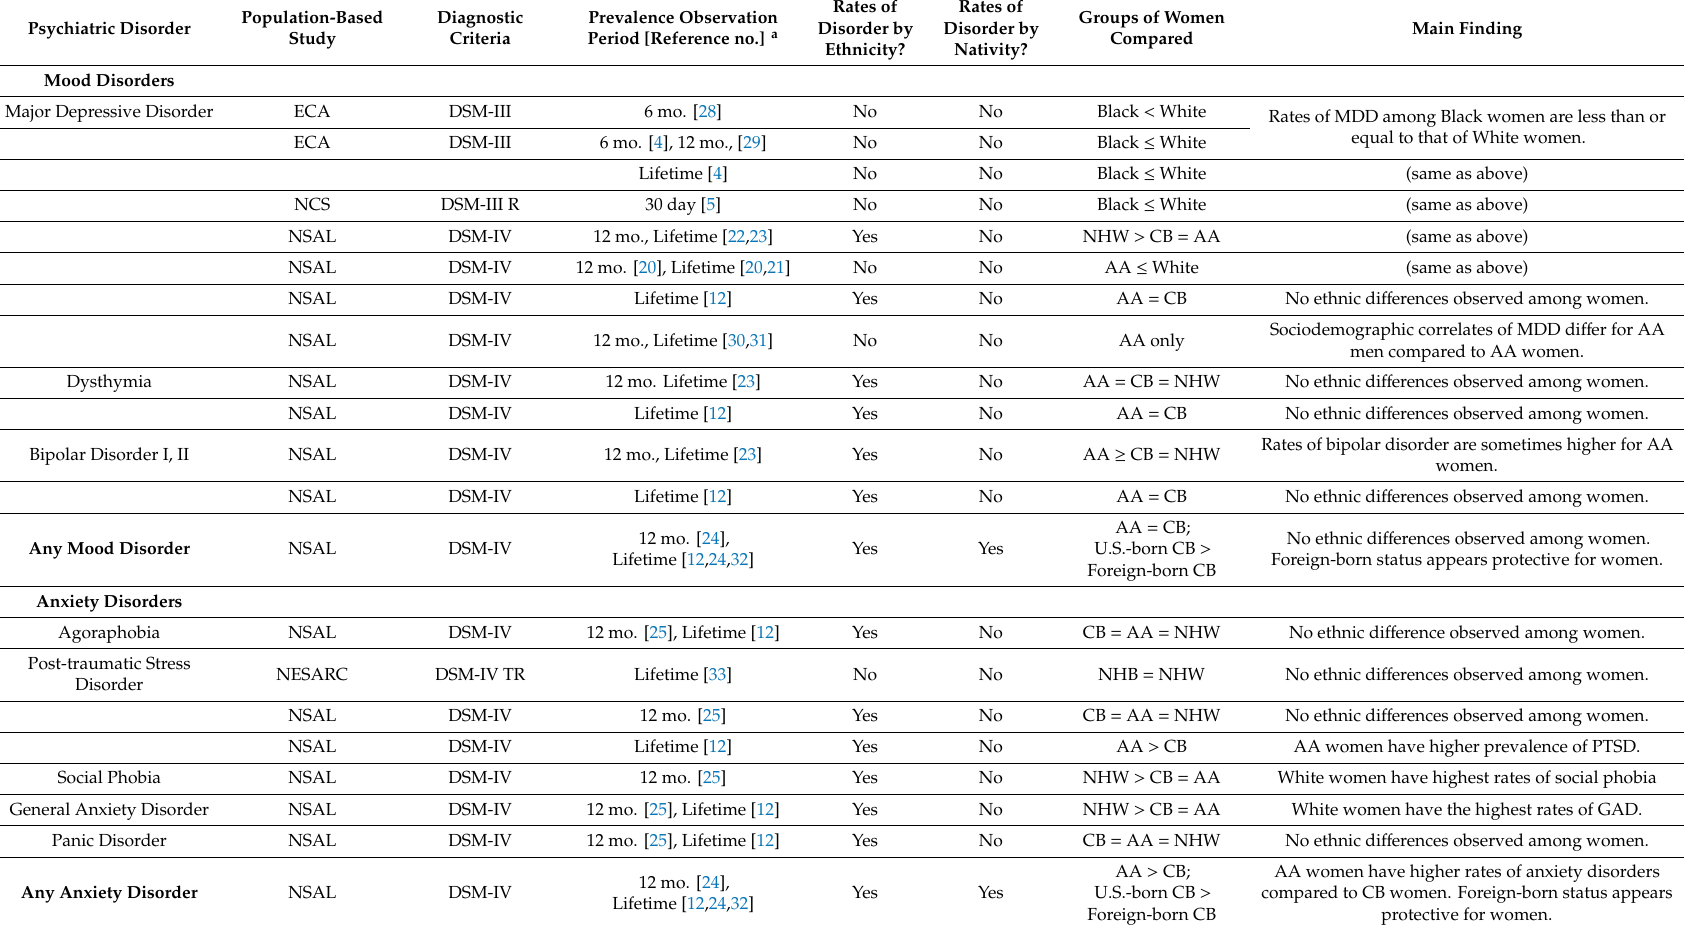
Table 1. Findings from previous population-based studies of specific DSM-IV mood, anxiety, and substance use psychiatric disorders in African American and Caribbean women in the